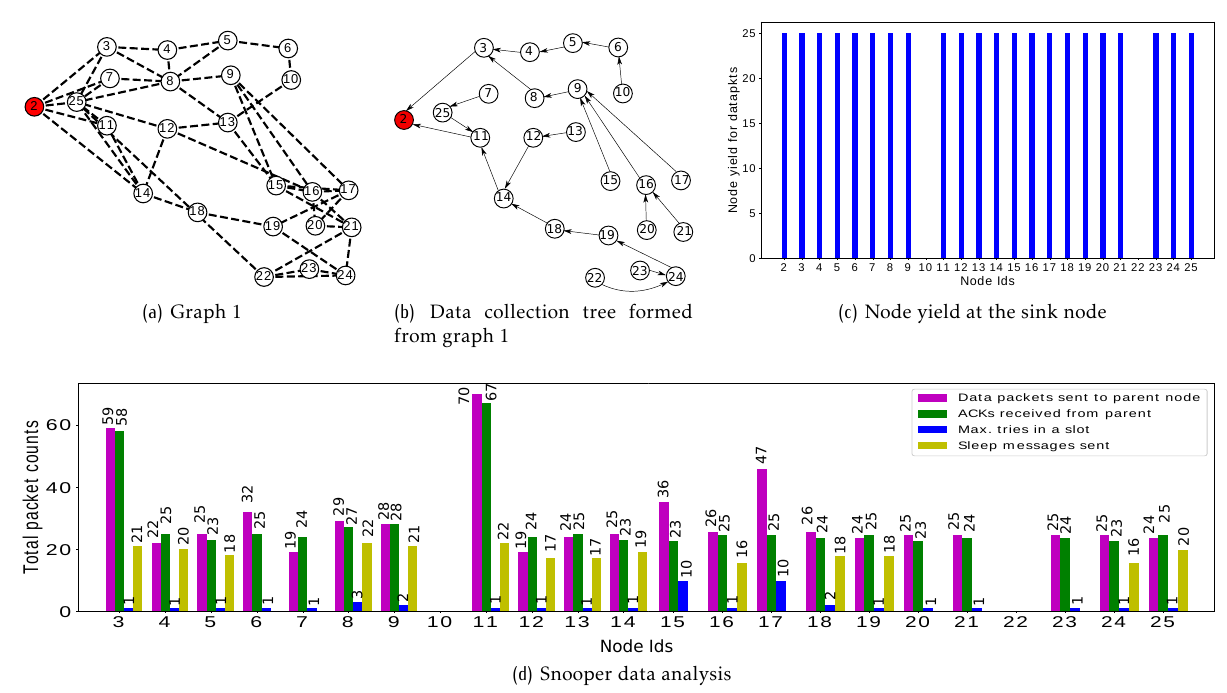
(d) Snooper data analysis Figure 28. Graph, respective data collection tree and the packet transmissions in the network - round 1, test case 3